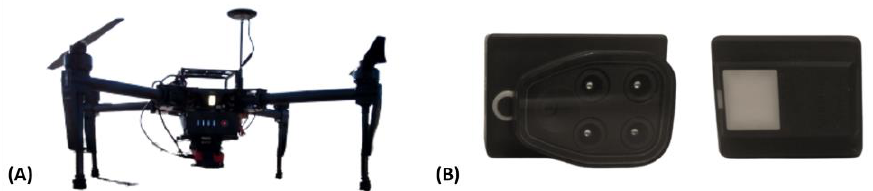
Figure 2. ( A ) RPA Matrice 100; ( B ) Parrot Sequoia and sunshine sensor.